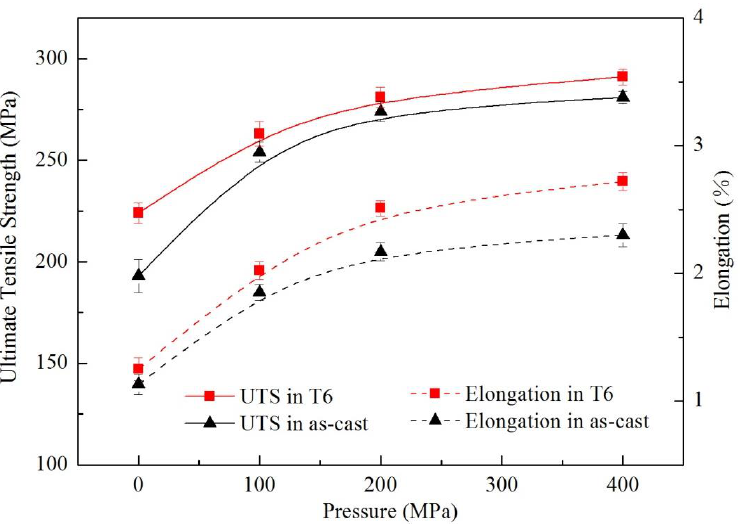
Figure 14. Ultimate tensile strength (UTS) and elongation of HPRSC A1 alloy with UV-ES compound field treatment.